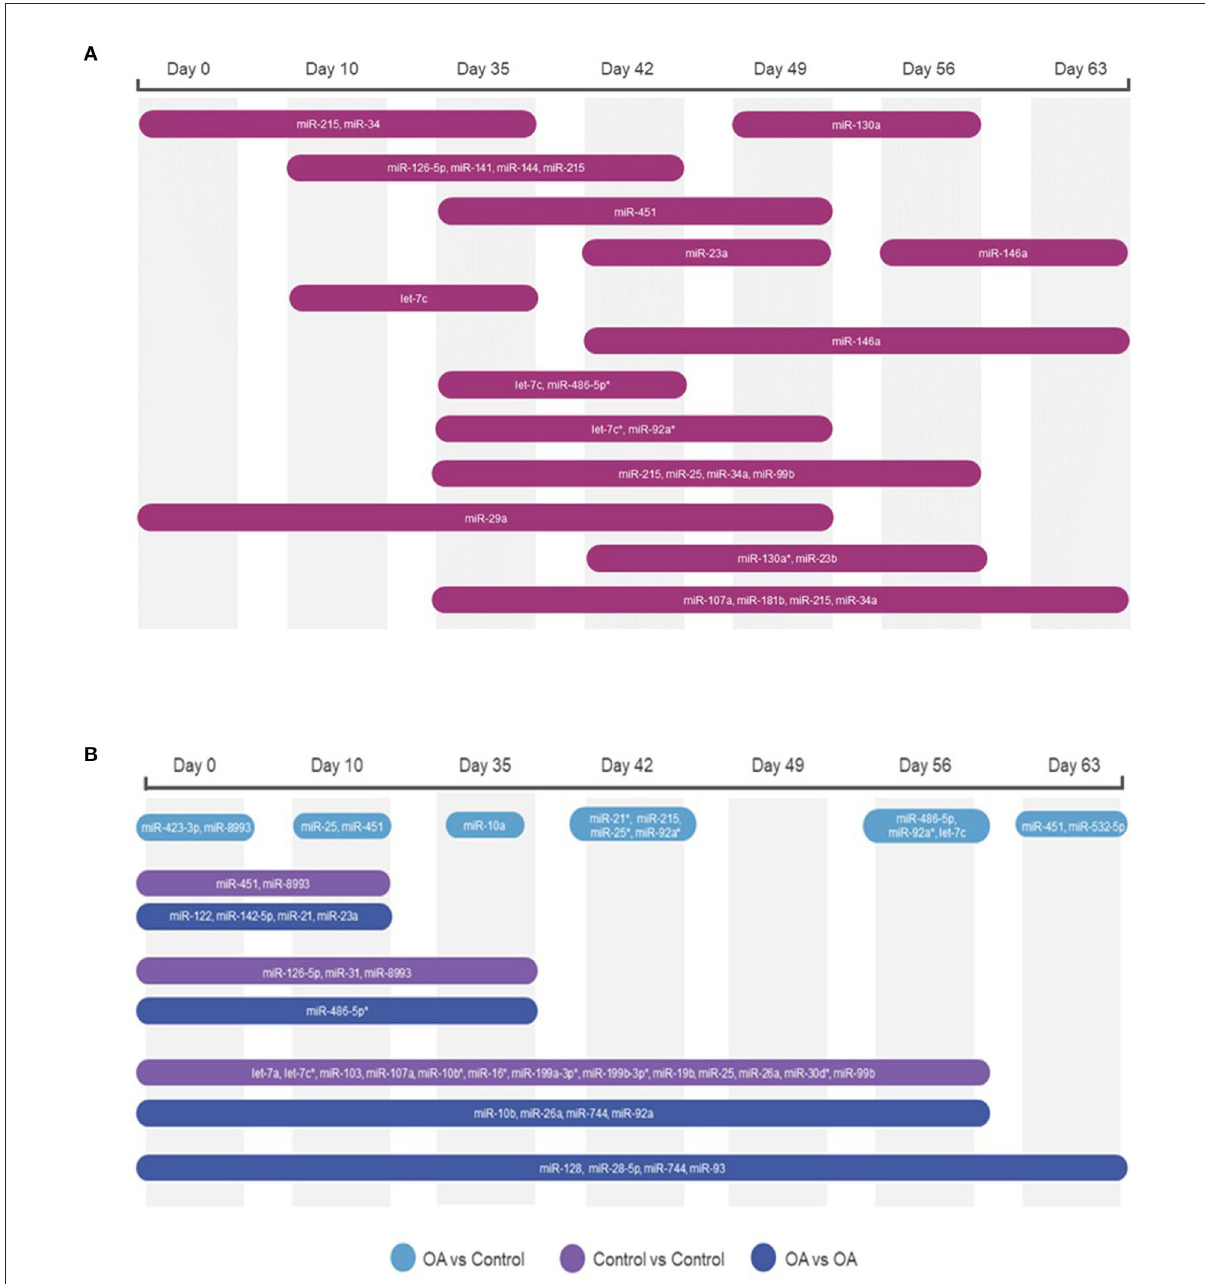
FIGURE7 Diagrams summarising the changing miRNA landscape in longitudinal EV samples following small RNA sequencing, miR, eca-miR. (A) Plasma-derived EV timeline. (B) Synovial fluid-derived EVs for time and diseases. MiRNAs were identified following pairwise comparisons. p < 0.05 and * denotes FDR <